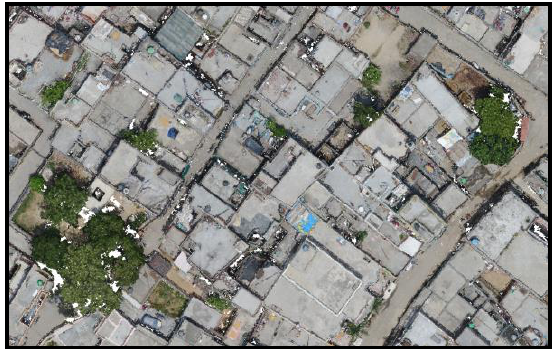
Figure 3: Original Point Cloud Dataset of the study area